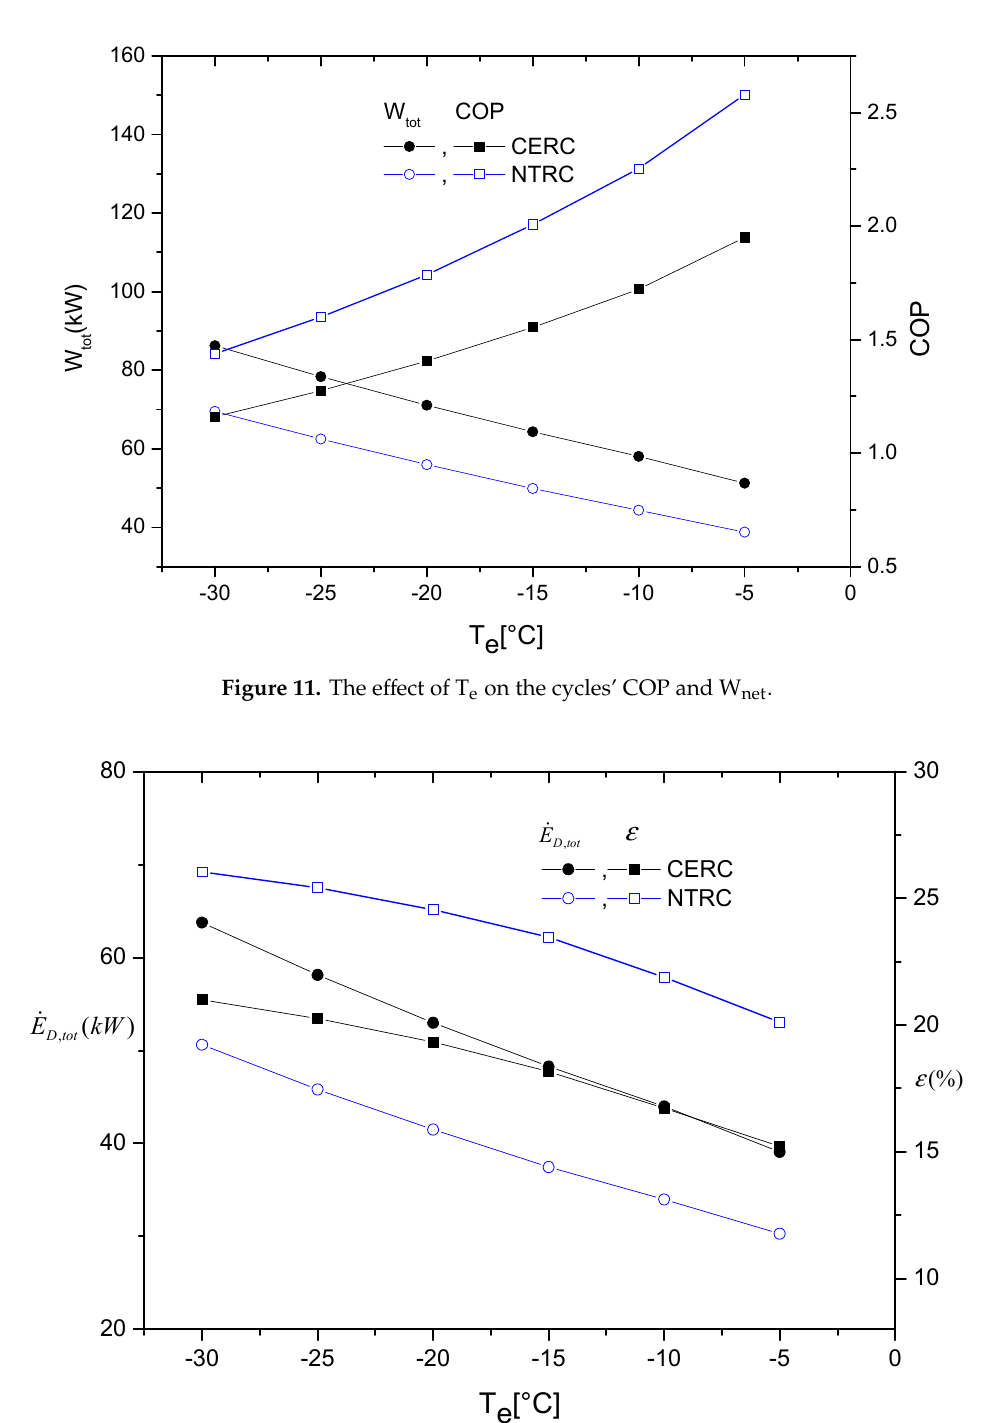
Figure 12. The dependence of the exergy efficiency (cid:2013) and overall amount of (cid:1831)(cid:4662) (cid:3005),(cid:3047)(cid:3042)(cid:3047) on evaporator